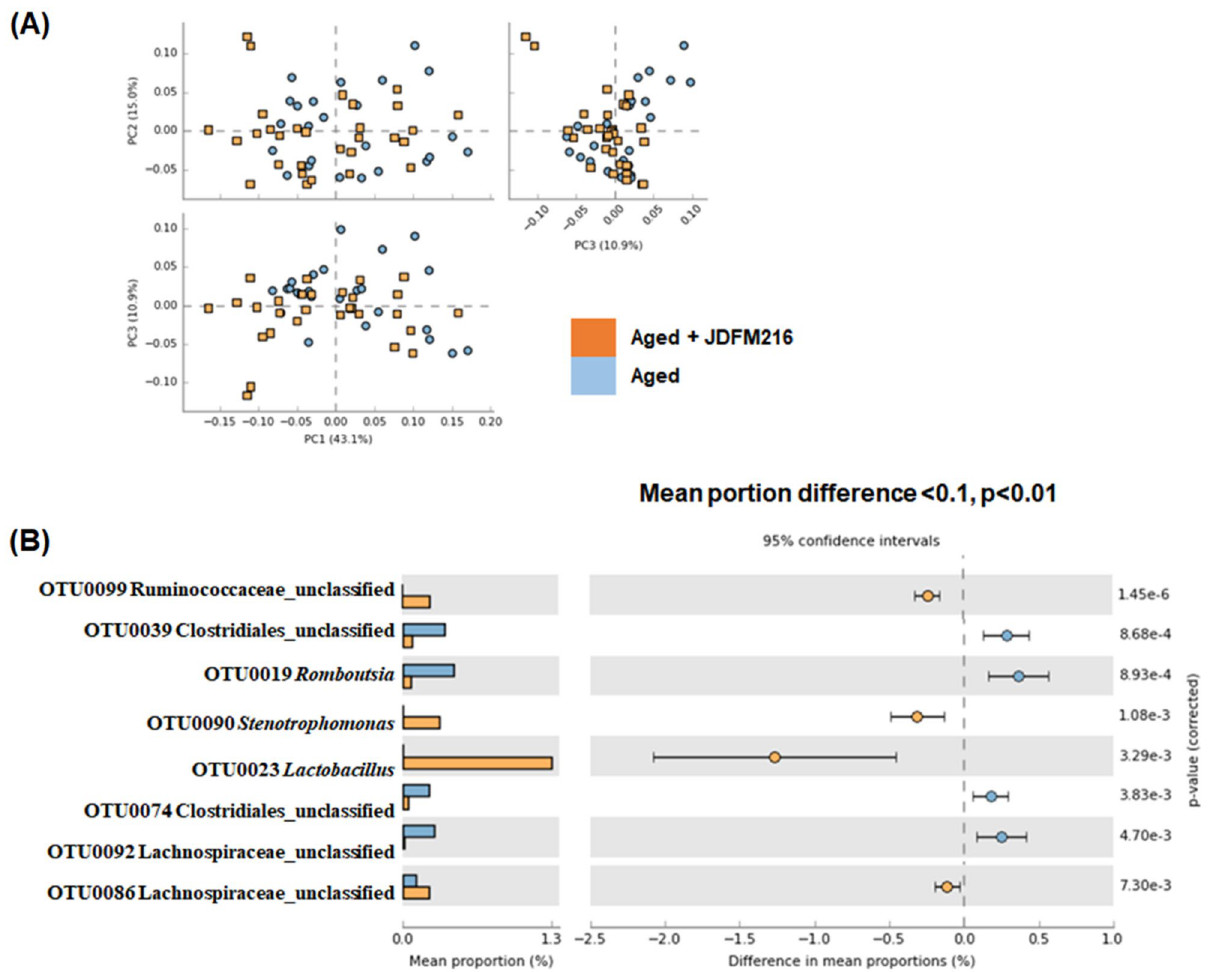
Figure 4. Comparison of gut microbiota between aged mice (Aged Groups) and aged mice fed Lactobacillus fermentum JDFM216 (Aged Groups + JDFM216) at 100 weeks based on principal component analysis ( A ) and operational taxonomic units (OTUs) with significantly different abundance ( B ). Corrected P values are shown on the right. The effect sizes and confidence intervals are provided to allow for critical assessment of the biological relevance of the test results. Significantly increased ( A ) and decreased OTUs ( B ) and by feeding